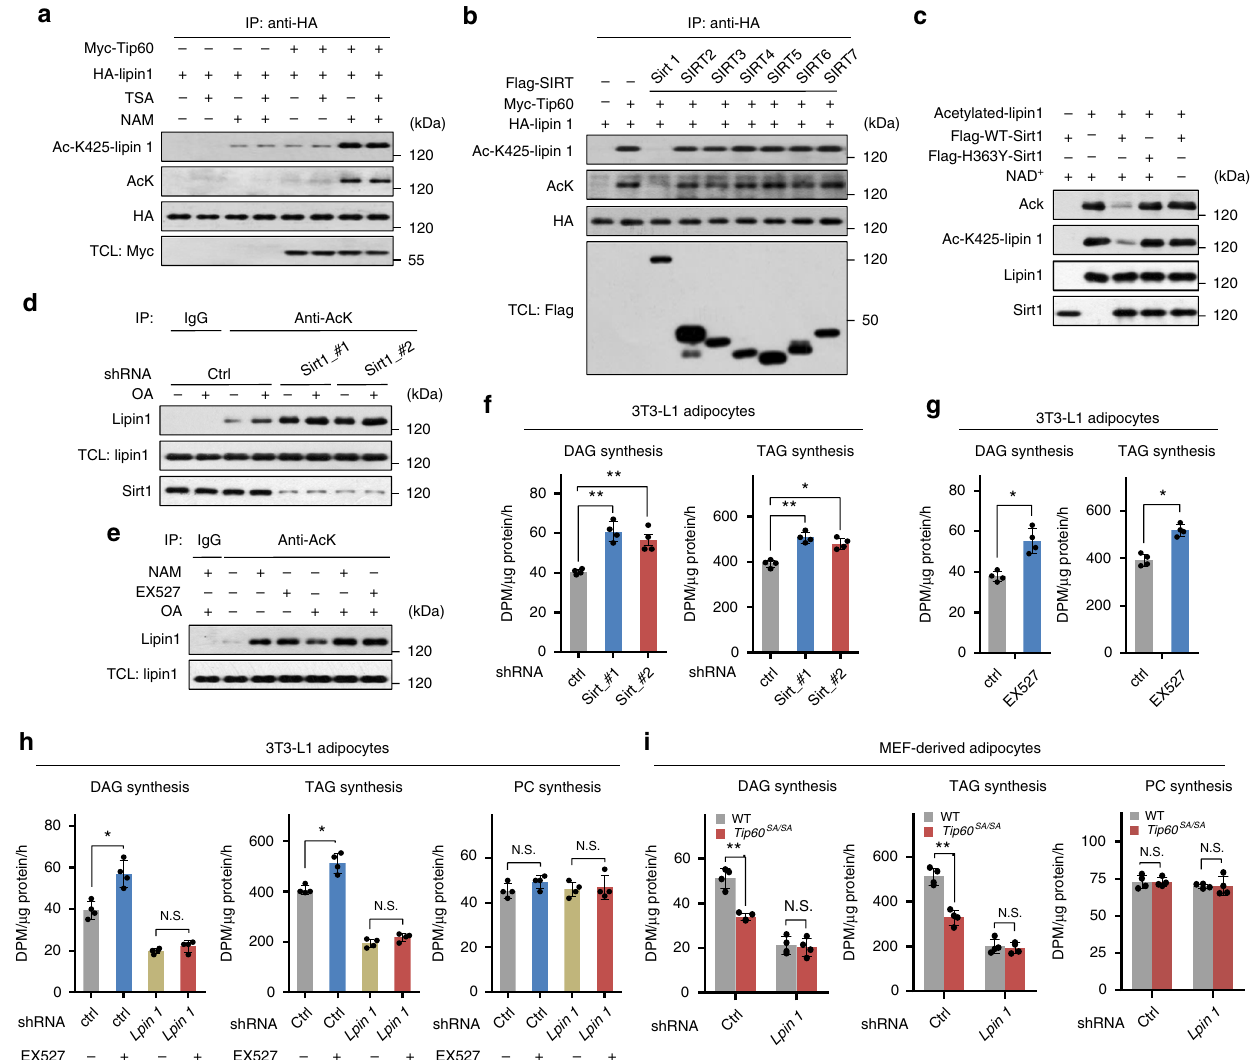
Fig. 4 Sirt1 deacetylates lipin 1 and represses the synthesis of DAG and TAG. a Sirtuins inhibitor nicotinamide (NAM) increases the amount of acetylated lipin 1. Lysates of HEK293T cells transfected with HA-lipin 1 and/or Tip60 treated with trichostatin A (TSA) (a class I and II HDAC inhibitor) or NAM for 6 h were immunoprecipitated with antibody to HA, followed by immunoblotting. b Deacetylation of lipin 1 by co-expression with Sirtuins. Lysates of HEK293T cells transfected with HA-lipin 1, Tip60 and Flag-tagged Sirt1 – 7 as indicated were immunoprecipitated with antibody to HA, followed by immunoblotting. c In vitro deacetylation of lipin 1 by Sirt1. Acetylated-lipin1 were incubated with Flag-tagged WT-Sirt1 or the inactive H363Y mutant (expressed and immunoprecipitated from HEK293T cells) in the presence or absence of NAD + for 1 h, followed by immunoblotting. d Knockdown of Sirt1 increases the amount of acetylated lipin 1. 3T3-L1 adipocytes expressing control shRNA (ctrl) or shRNAs targeting Sirt1 were treated with or without OA